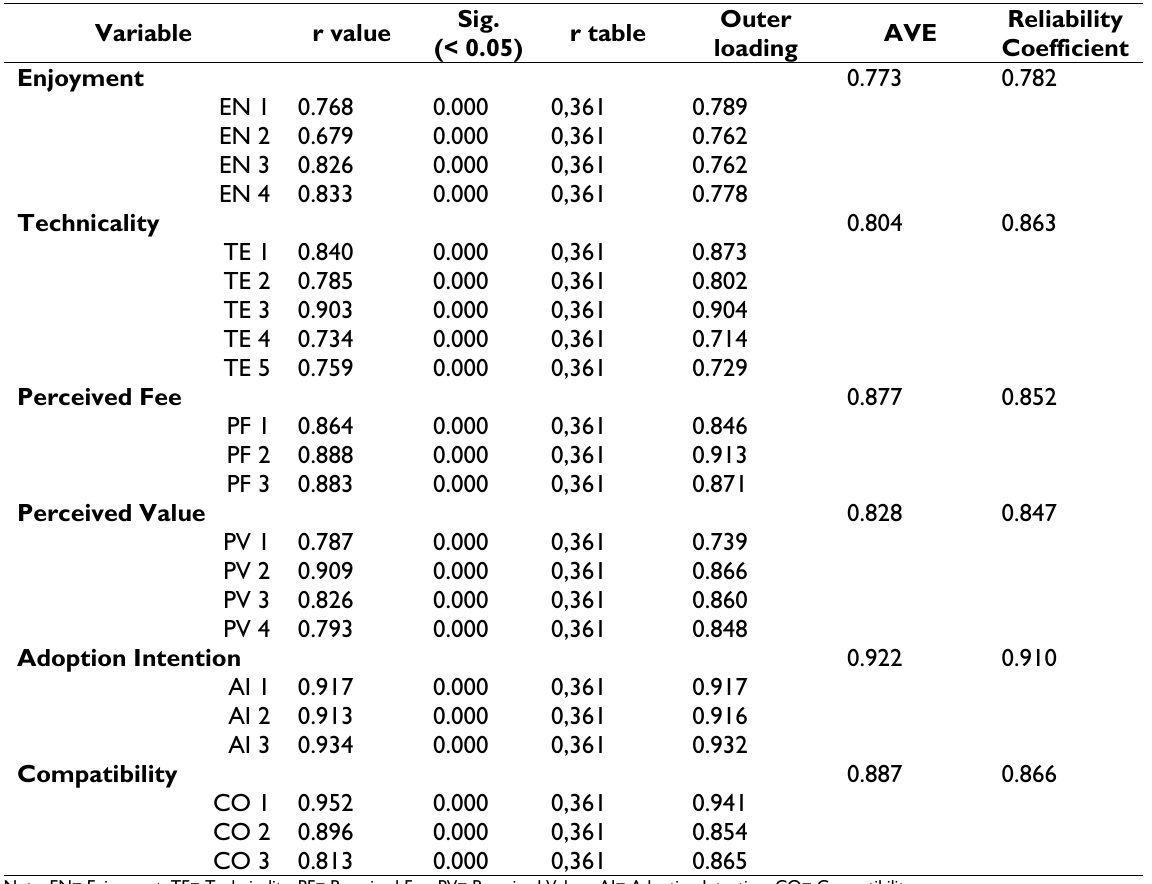
Table 3. Validity and Reliability